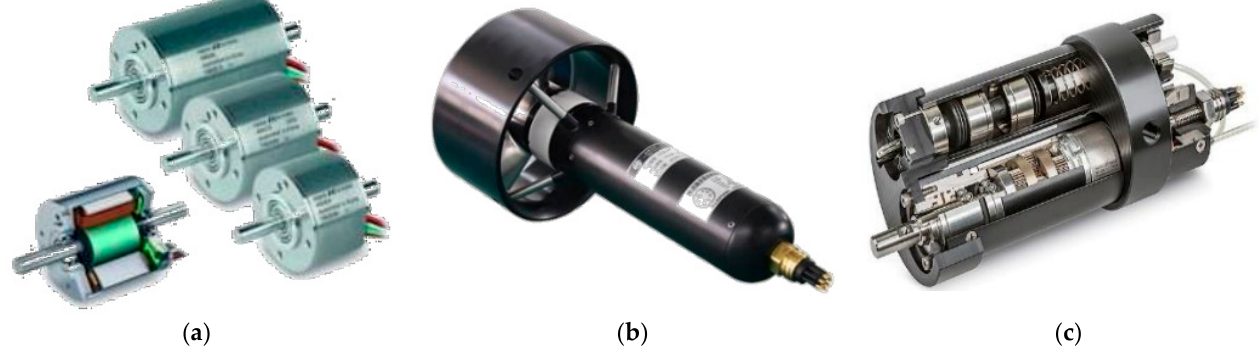
Figure 2. ( a ) High-torque brushless DC motors used in unmanned underwater vehicles (image credit Unmanned Systems Technology [6]). ( b ) Underwater thruster propeller motor (image credit Maxon [8]). ( c ) ECI-40 Maxon underwater drive motor and gear head (image credit Maxon [8]).